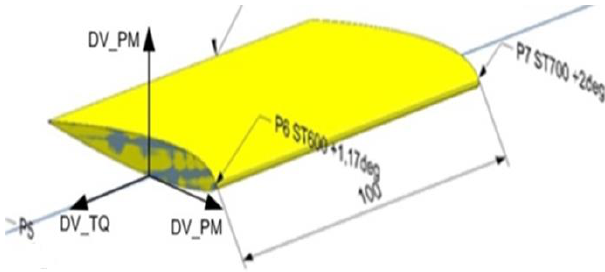
Fig. 1. Profile section intended for the determination of aerodynamic loads